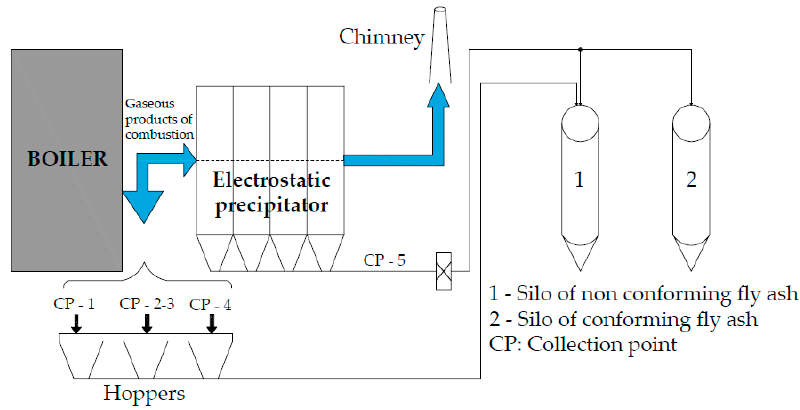
Figure 1. Scheme of fly ash production in a conventional thermoelectric power plant.